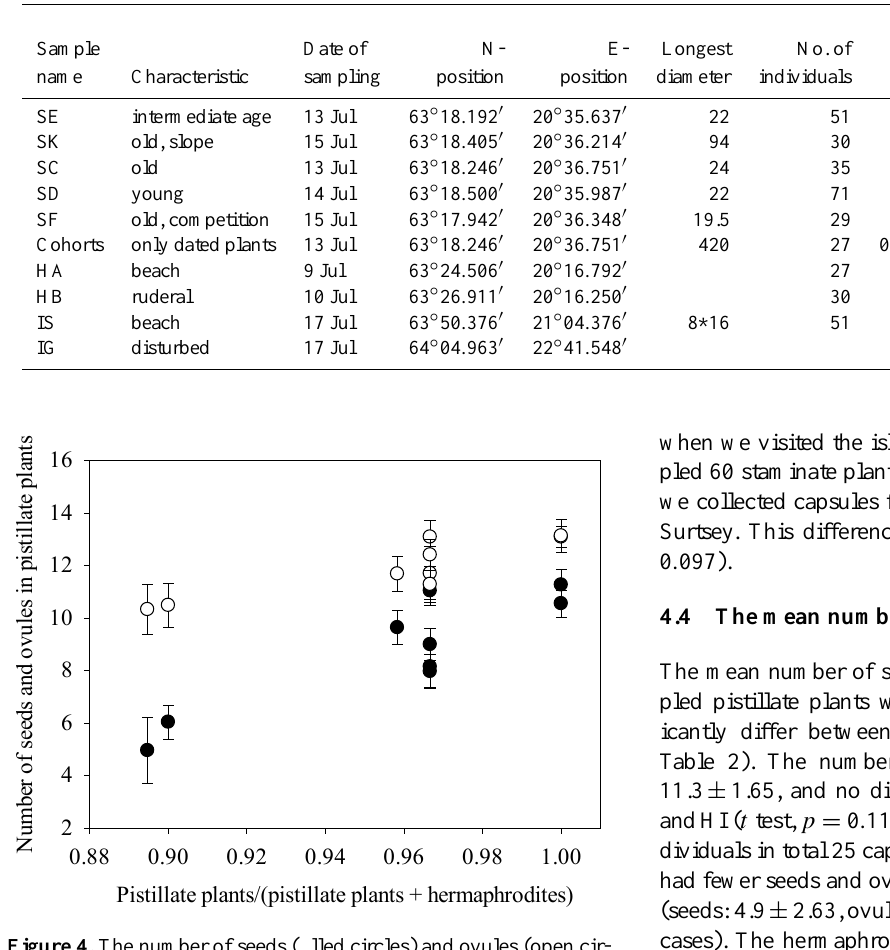
Figure 4. The number of seeds (filled circles) and ovules (open cir- cles) (with error bars, SE) increased as the frequency of pistillate plants increased in relation to the total number of female function- ing plants (pistillate + hermaphrodites) in Honckenya peploides